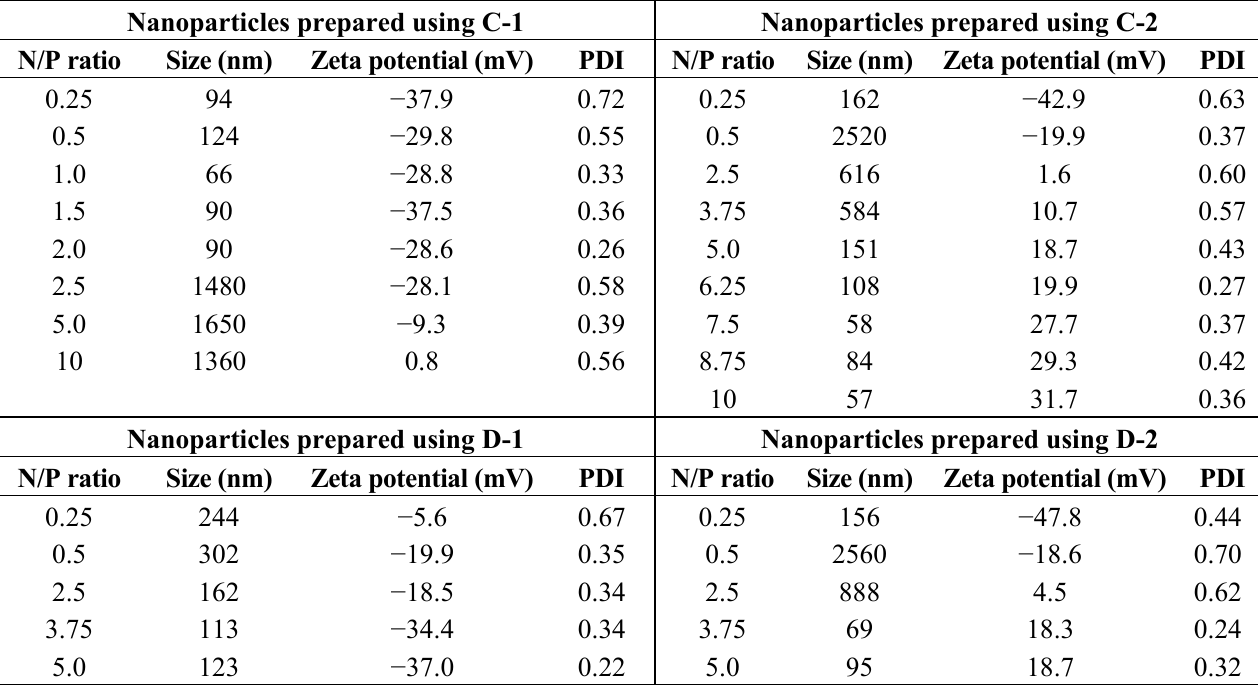
Table S1. Characteristics of nanoparticles of siRNA targeting GFP prepared using various MCDs at a range of N/P